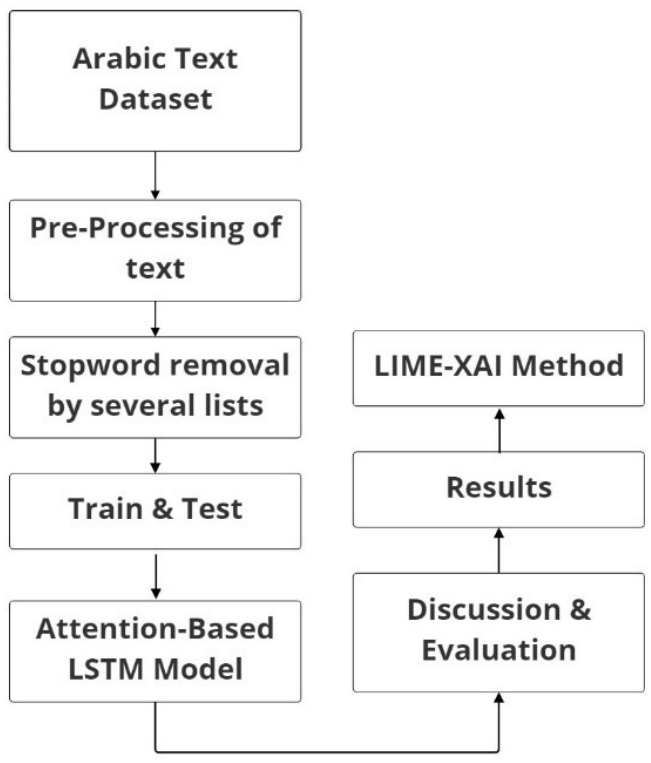
Figure 1. Flowchart of Applied Approach.